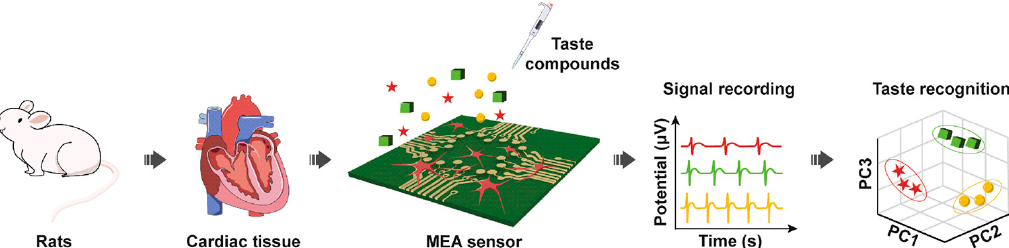
Figure 6. Schematic diagram of biosensor construction and bitter taste detection with rat cardiomy- ocytes on an MEA sensor chip. Reproduced from [109] with permission from Elsevier.